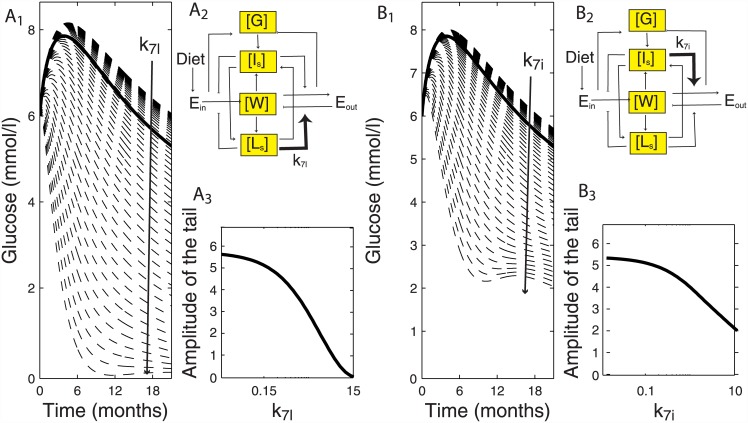
Leptin- and insulin-mediated negative-feedbacks control the blood glucose response.Insulin (k
7i) and leptin (k
7l) mediated negative-feedback regulating energy expenditure via Eout (A2, B2). At the later age, leptin has a stronger impact on the blood glucose dynamics. Arrow depicts the direction of fold-change increase in k
7i and k
7l (A1, B
1,). Amplitude of the blood glucose tail is more strongly affected by leptin-mediated negative-feedback (k
7l) compared to insulin-mediated negative-feedback (k
7i) (B3, A3). Sufficiently strong negative-feedback (e.g. 50 fold increase in k
7l, and k
7i) leads to a second rise in blood glucose levels (A1 and B1).